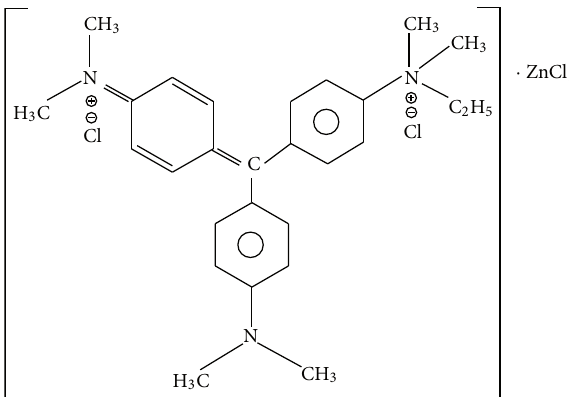
F 1: Chemical structure of